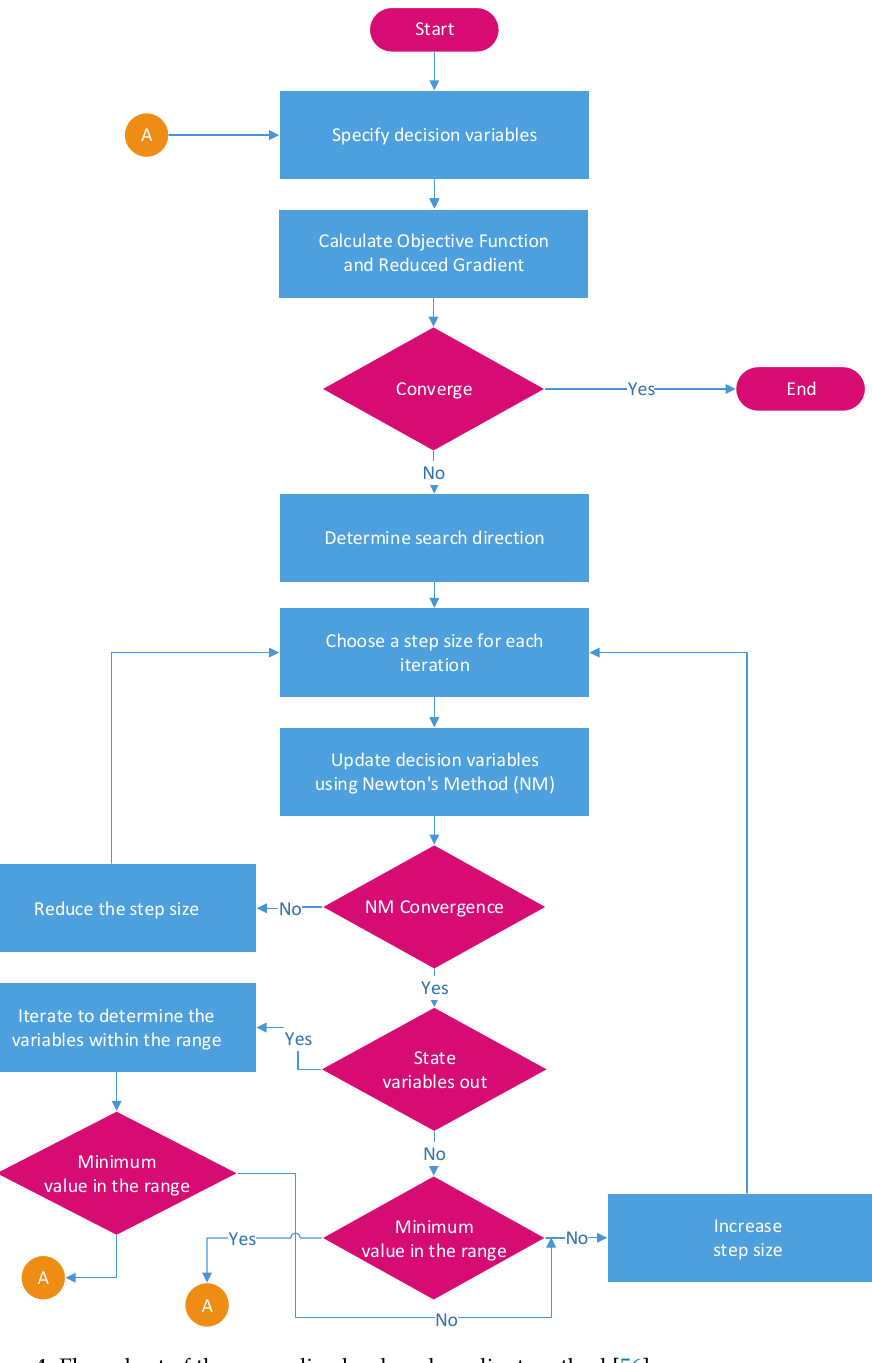
Figure 4. Flow chart of the generalized reduced gradient method